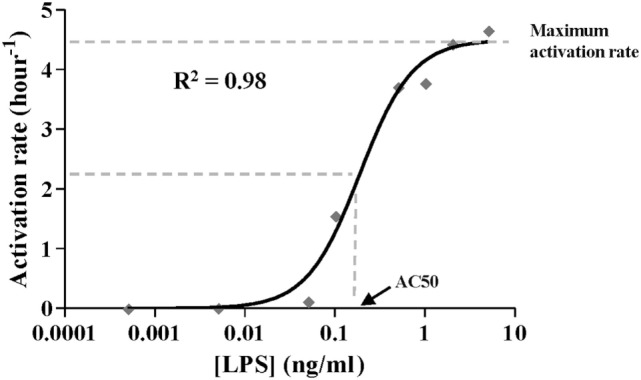
Activation rate expressed as Hill function. The black line corresponds to the function optimized by dose–response non-linear regression analysis to fit estimated values (gray diamonds) shown in Table 5. The coefficient of determination R2 is presented. [LPS] refers to the lipopolysaccharides concentration in the first stimulus.